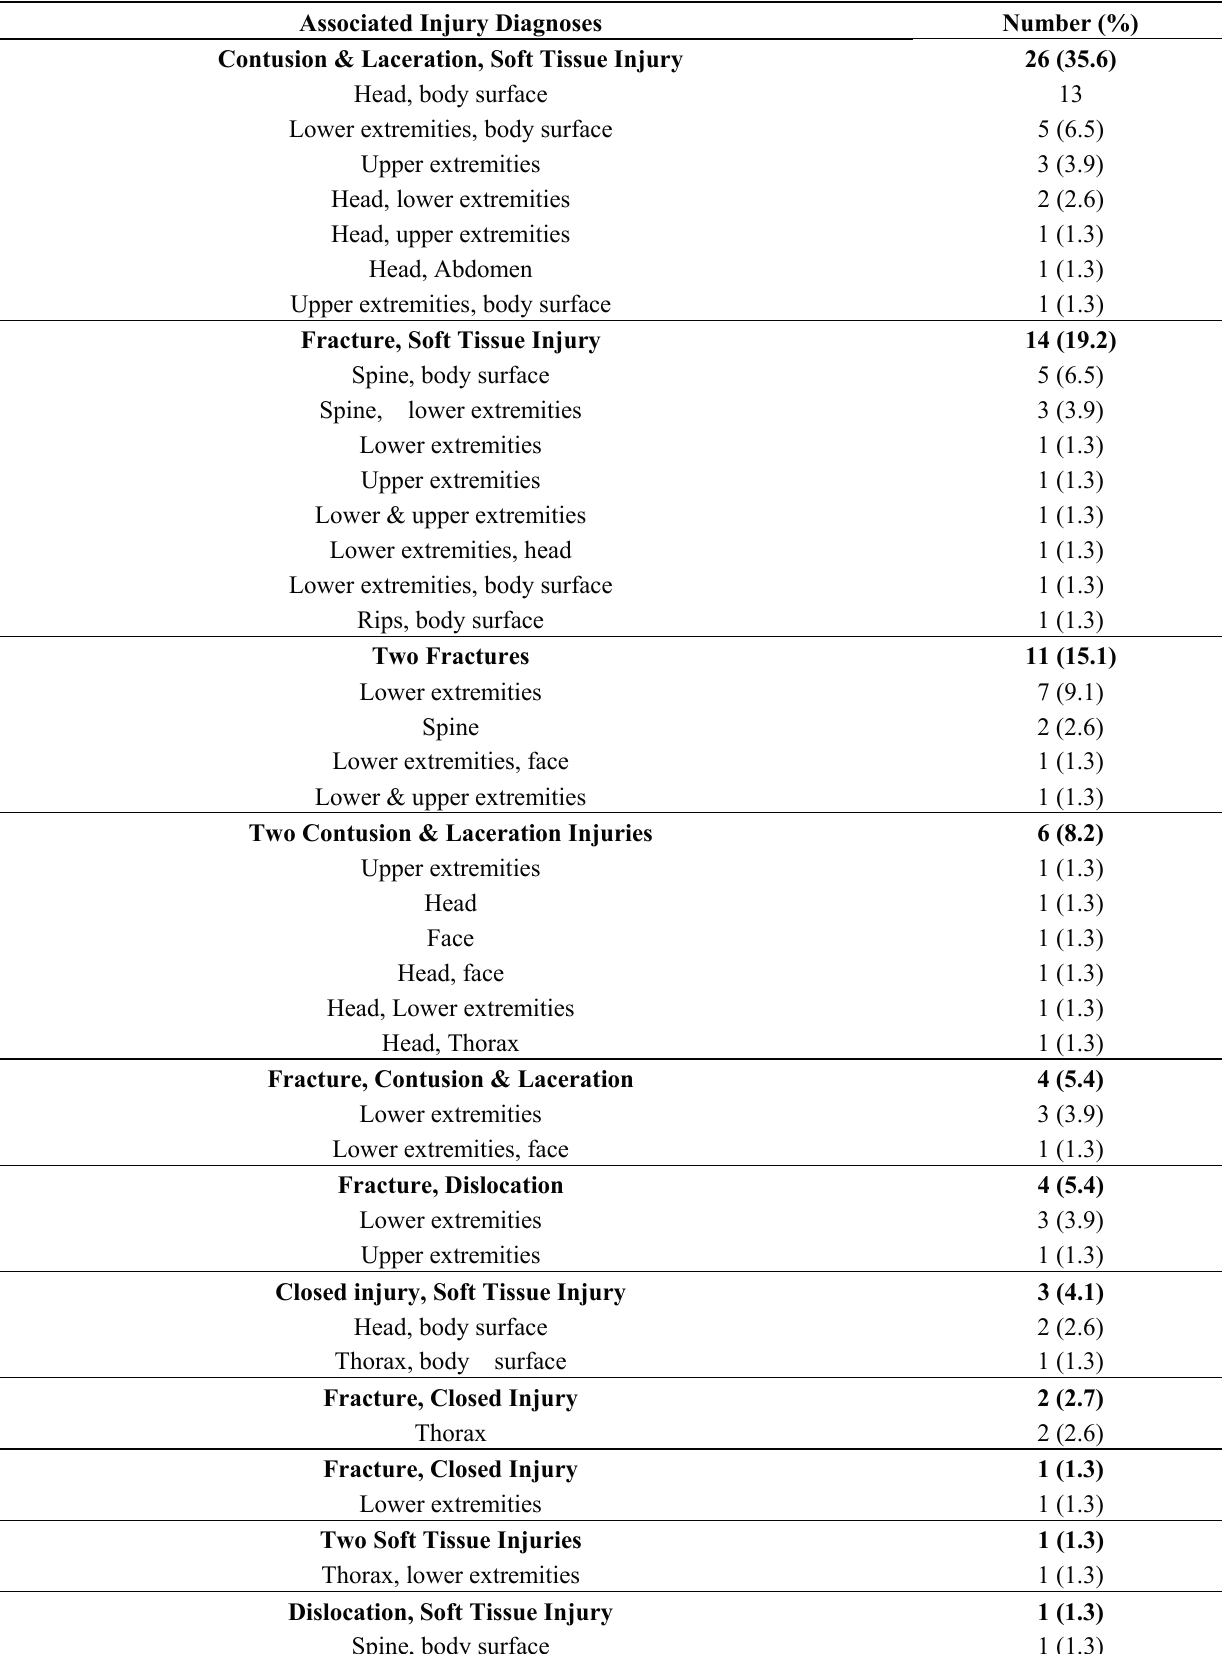
Table 5. Most frequent combinations of injury diagnoses by body region in 73 two-injury patients. Associated Injury